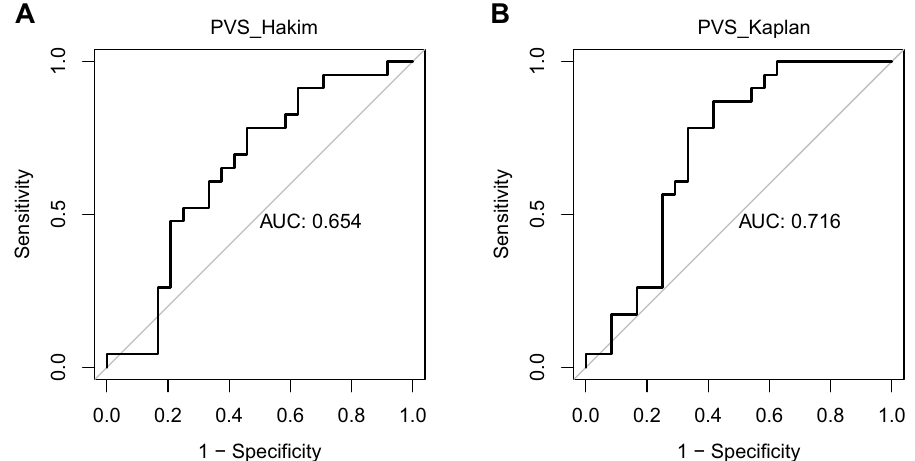
Figure 1. Area-under the curve for the prediction of true plasma volume excess by plasma volume status as calculated by the so-called Hakim formula ( A ) and the Kaplan formula ( B